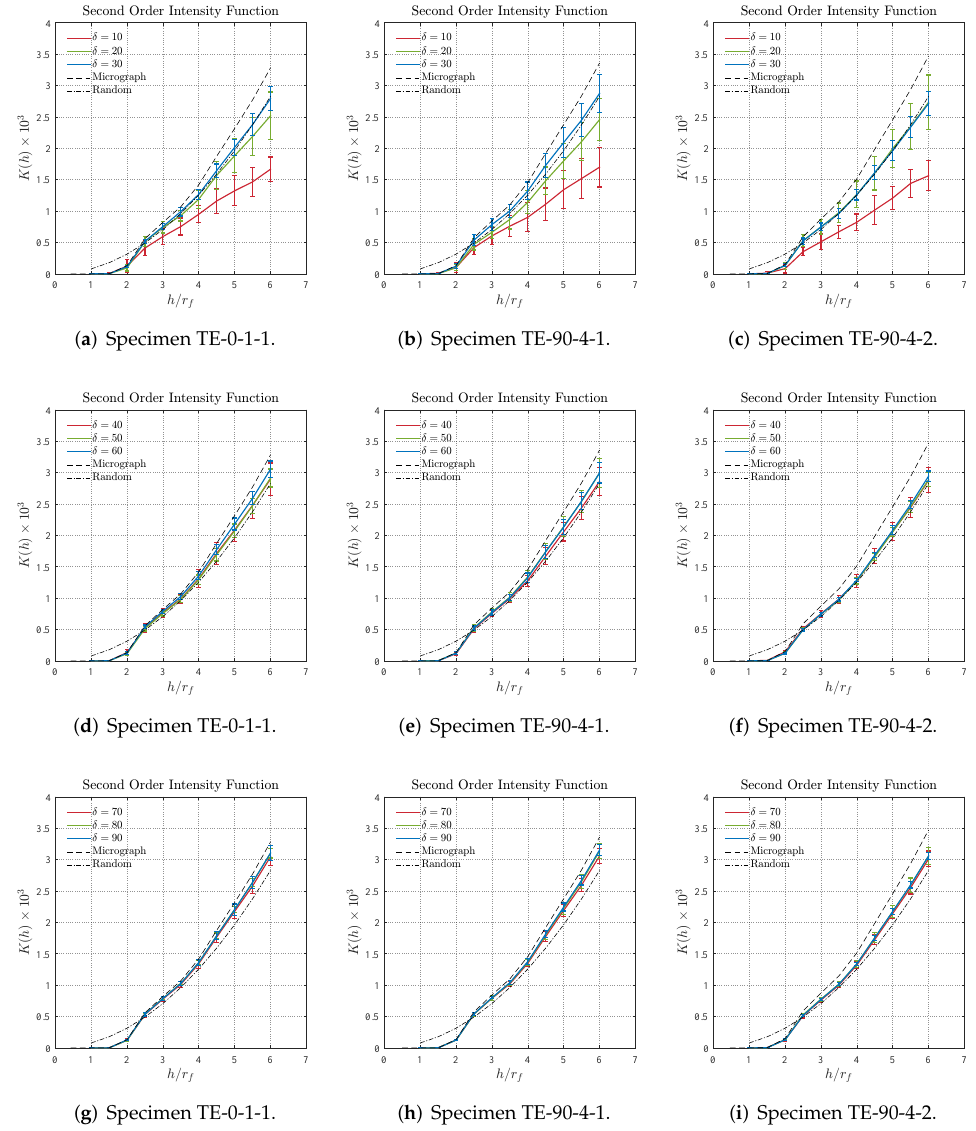
Figure 13. Second-order intensity function obtained for cropped regions of size δ = [ 10,90 ] , as well as for the main region of the cross-section micrograph (dashed lines) and for a complete random distribution (dash-dotted